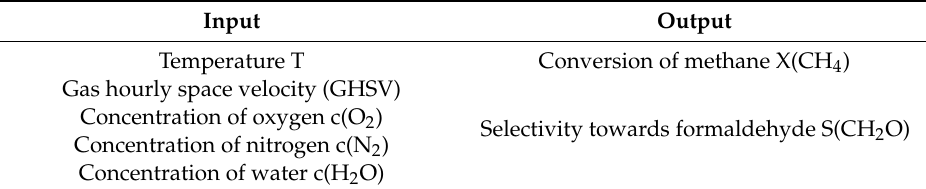
Table 2. Input and output variables used for ANN